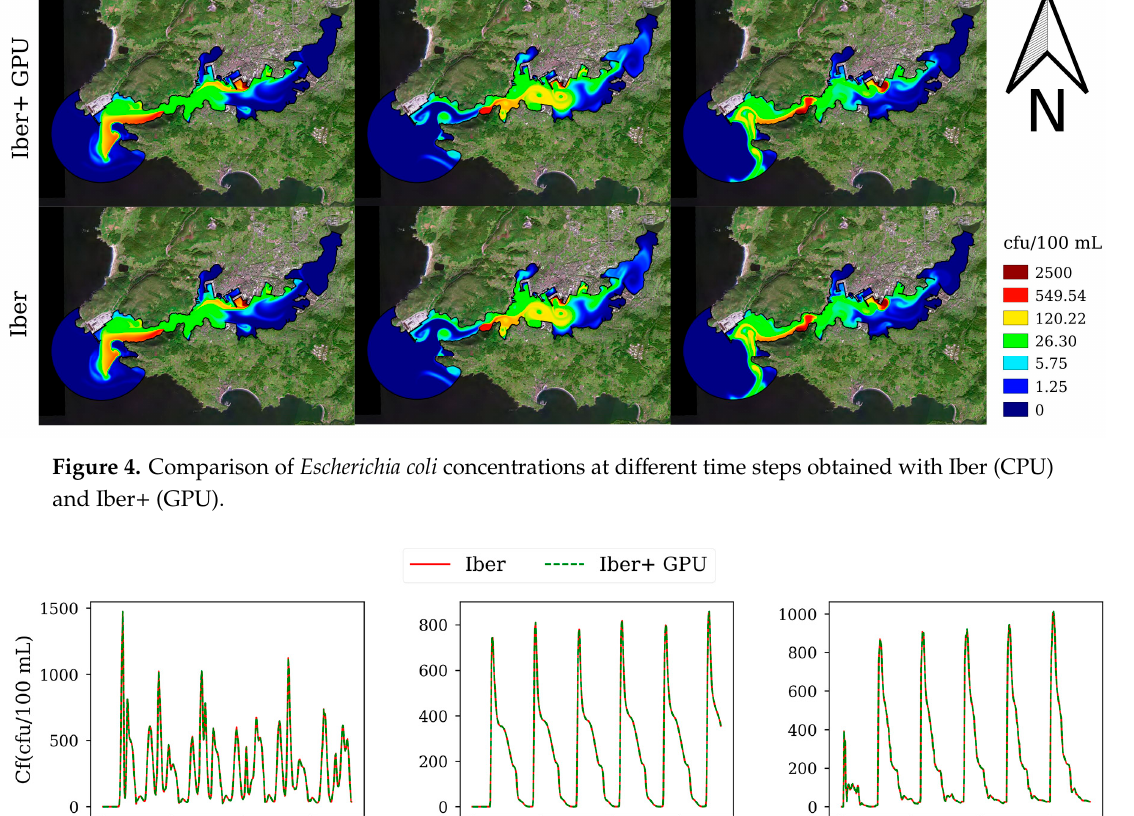
Table 1. Performance measurements obtained for the first test case (estuary of Ferrol).